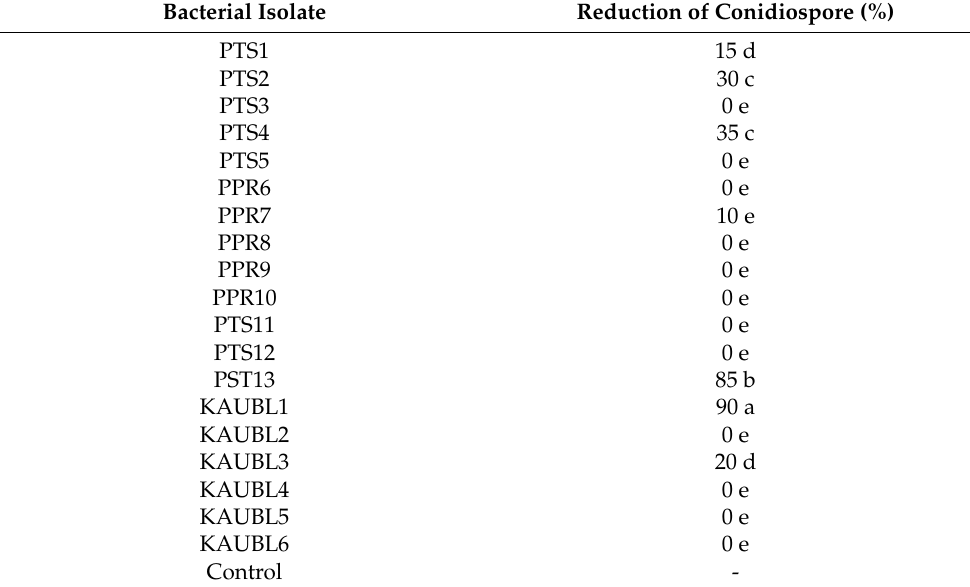
Table 1. In vitro inhibition of conidiospore of P . xanthii by bacterial bioagents isolates. Bacterial Isolate